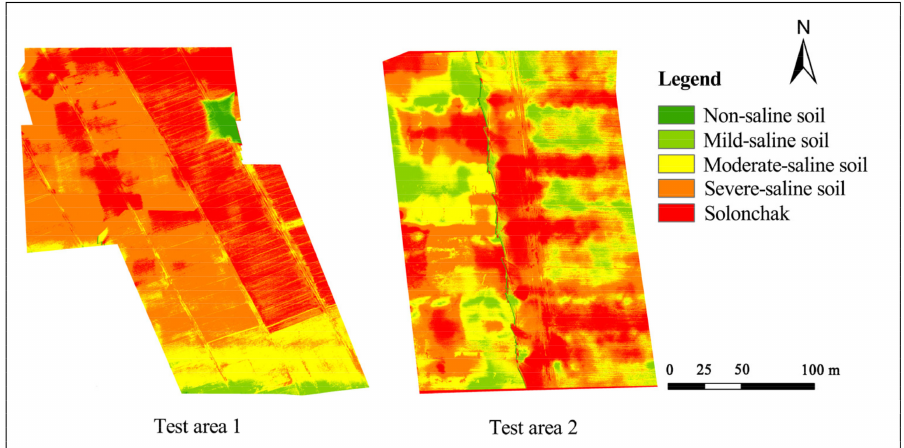
Figure 8. Estimation map of soil salt content in the test